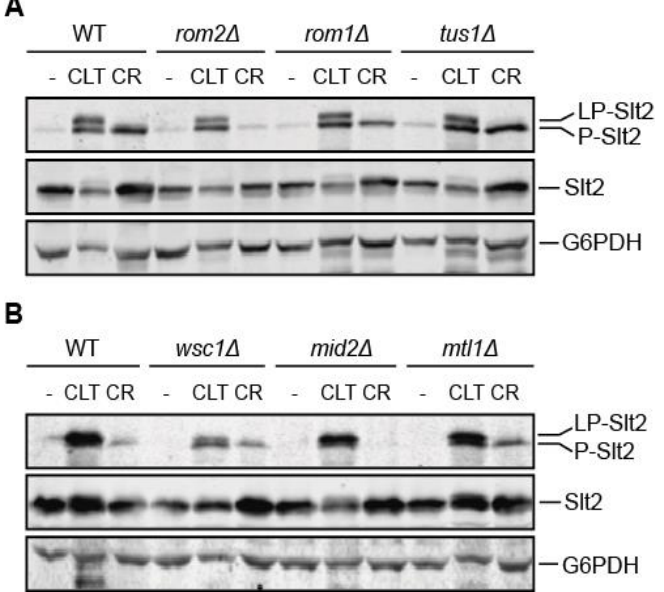
Figure 4. Involvement of components upstream of Pkc1 in clotrimazole-triggered signaling through the CWI pathway. ( A , B ) Western blotting analysis of extracts of BY4741 (WT) and the indicated isogenic mutant strains. Cells were cultured without stimulus (-), with 50 µg/mL of CLT, or with 30 µg/mL of CR for 4 h at 24 °C. Dually phosphorylated Slt2, Slt2 protein, and G6PDH (as a loading control) were detected with anti-phospho-p44/42, anti-Mpk1, and anti-G6PDH, respectively. Representative blots from three independent experiments are shown.